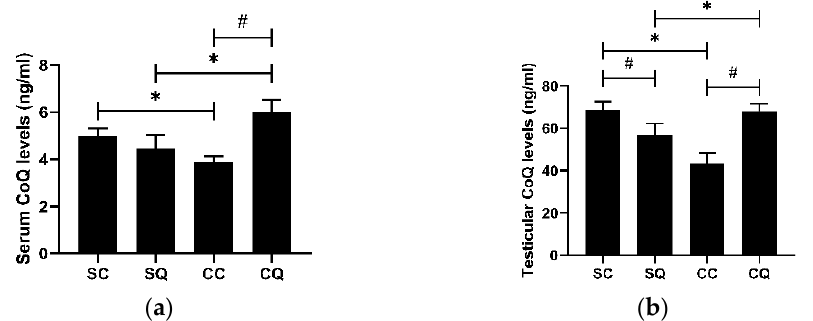
Figure 1. CoQ levels in ( a ) the serum and ( b ) the testes of the sham surgery and CKD surgery mice treated with vehicle (corn oil) or CoQ10. SC: sham surgery mice with vehicle; SQ: sham surgery mice with CoQ10; CC: CKD surgery mice with vehicle; CQ: CKD surgery mice with CoQ10. Data are expressed as the mean ± SD ( n = 4–5 per group). * p < 0.05 denotes a significant difference between the sham surgery and CKD surgery groups (SC vs. CC and SQ vs. CQ); # p < 0.05 denotes a significant difference between the vehicle treatment and CoQ10 treatment groups (SC vs. SQ and CC vs. CQ). CoQ10, coenzyme Q10.